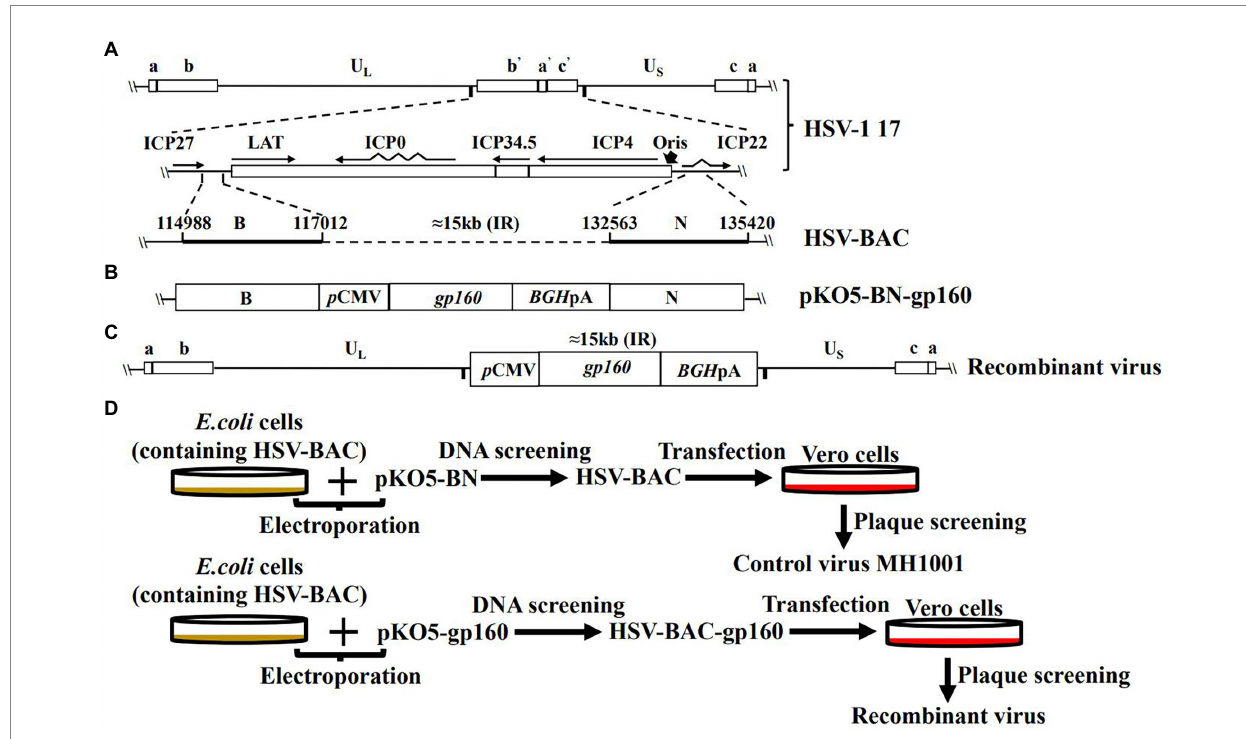
FIGURE 1 Genomic structures of HSV-1 recombinant vectors and recombinant virus constructs. (A) Schematic diagram of the wild-type HSV-1 genome. The HSV-1 genome consists of unique long (UL) and short (US) regions flanked by inverted repeat (IR) sequences. a, a ′ = terminal repeats; b, b ′ = L component inverted repeats; c, c ′ = S component inverted repeats. In the HSV-1 recombinant vector, a 15-kilobase (kb) fragment, including one copy of latency-associated transcripts (LATs), ICP0I, CP34.5, ICP4, was deleted to generate HSV-BAC. (B) Schematic diagram of composition of pKO5-BN- gp160. The recombinant shuttle plasmid vector was obtained after insertion of gp160 sequences into the cloning site through recombination of the upstream and downstream (N) arm within IR of pKO5. Then the recombinant HSV-1 virus (C) with gp160 gene was acquired by BAC triggered homologous recombination between pKO5-BN-gp160 and HSV-BAC, as shown on the flowchart (D) . CMV, promoter/enhancer sequences of the CMV IE gene; PA, polyadenylation